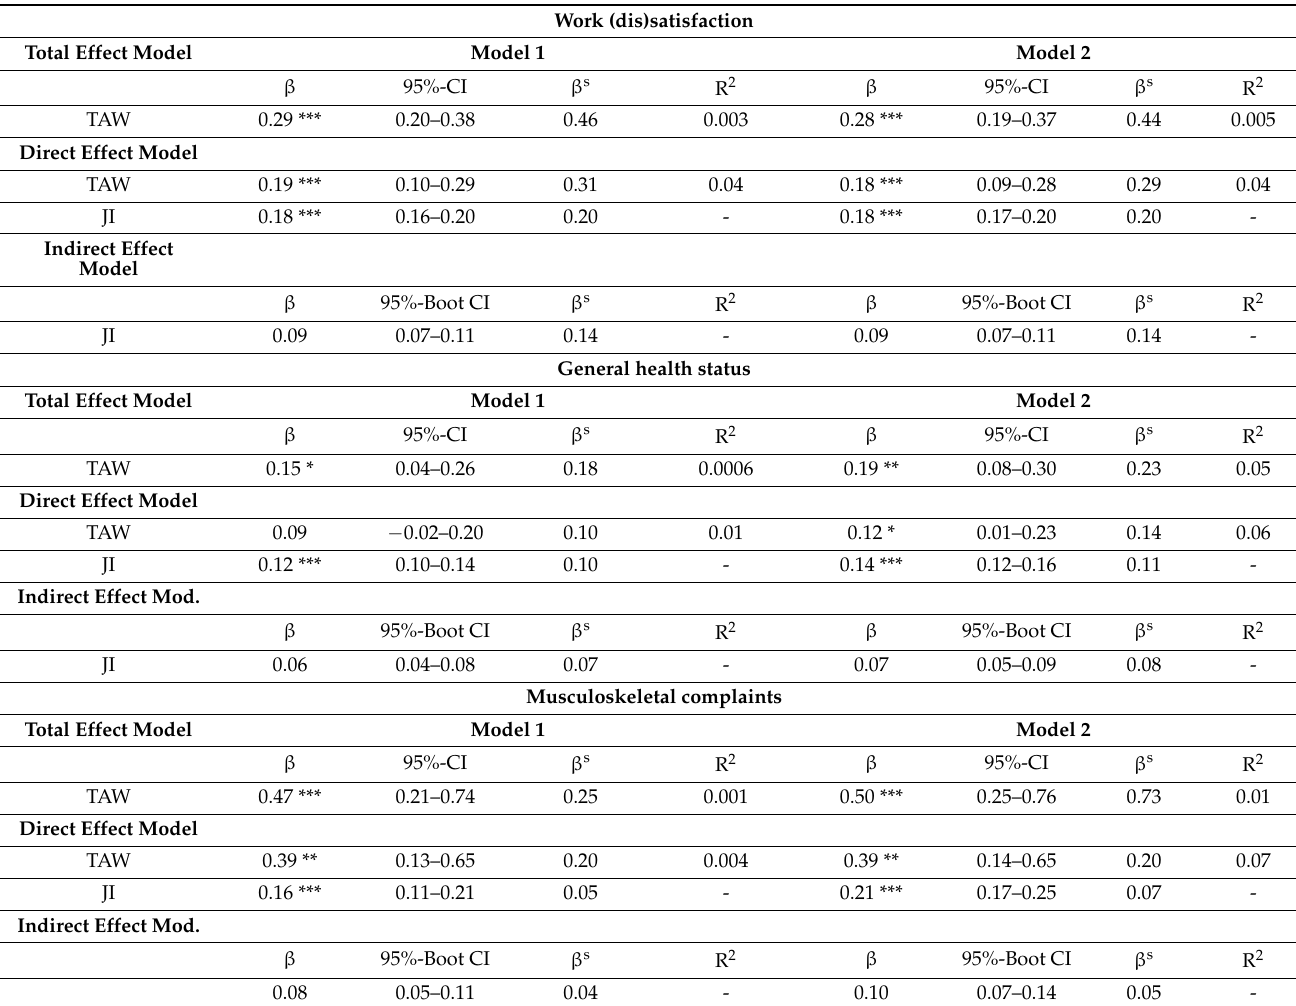
Table 3. Mediation analyses of TAW, JI, work (dis)satisfaction, general health and musculoskeletal